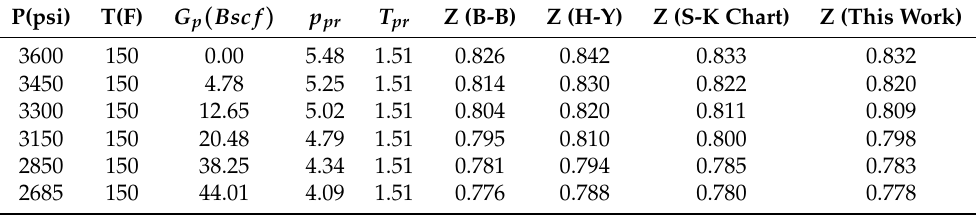
Table 3. Production data and the predicted Z-factor values at various pressure steps (Case Study